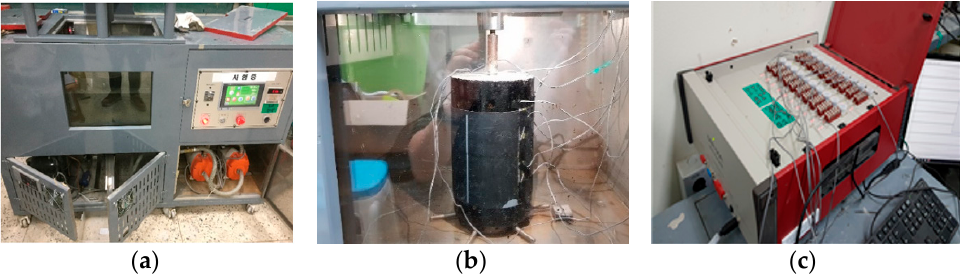
Figure 5. Testing apparatus illustrated: ( a ) crack/joint movement simulator testing machine (UTM) (Construction Technology Research Center, Nowon-gu, Seoul, Korea), ( b ) specimen installed with strain gauges and ( c ) data acquisition system apparatus.